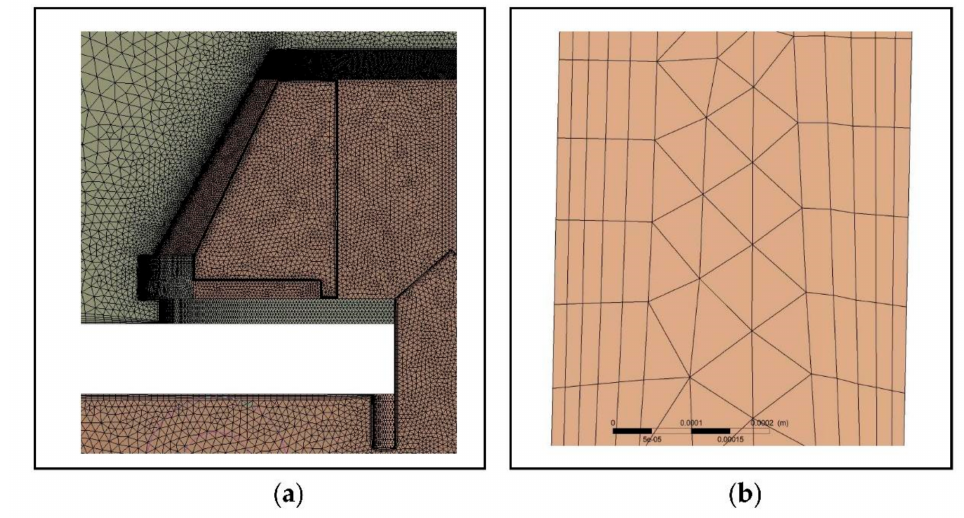
Figure 3. Detail of the mesh applied to ( a ) the influence zone of the underdrain element (half section view); ( b ) the open area of the slots of the underdrain (see layers of 5 prisms attached to lateral walls; the total length of the yardstick is 0.2